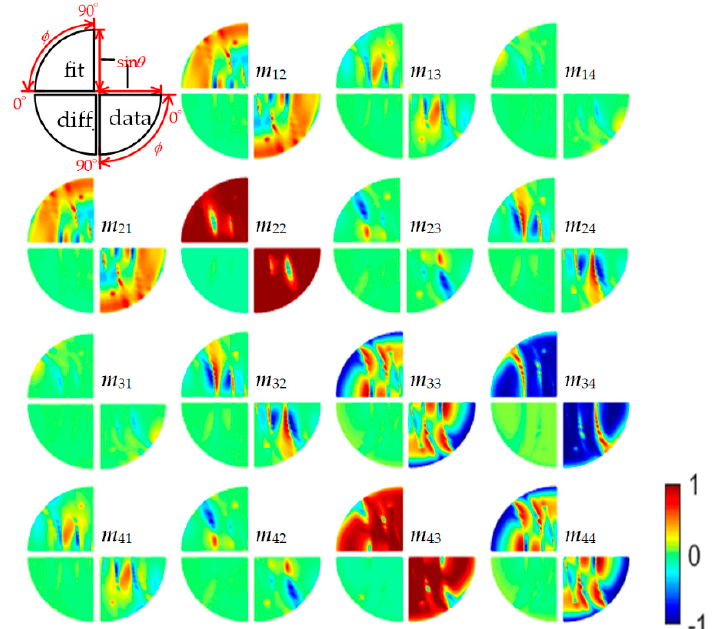
Figure 5. Mueller matrix representation of the zeroth-order diffracted field of the photoresist grating collected at the wavelength of 633 nm. The incidence angles varied from 0° to 65° at interval of 1°, and the azimuthal angles from 0° to 90° at interval of 5°. The panel associated with each Mueller matrix element (normalized to m 11 ) consists of three sectorial parts. The lower right part corresponds to the TMS-measured data, the upper left part corresponds to the calculated best-fit data, and the lower left part presents the difference between the measured and calculated best-fit data. For each sectorial part, the polar coordinate system is set as shown in the inset with the radial coordinate being the sine of the incidence angle sin θ and the angular coordinate being the azimuthal angle φ .